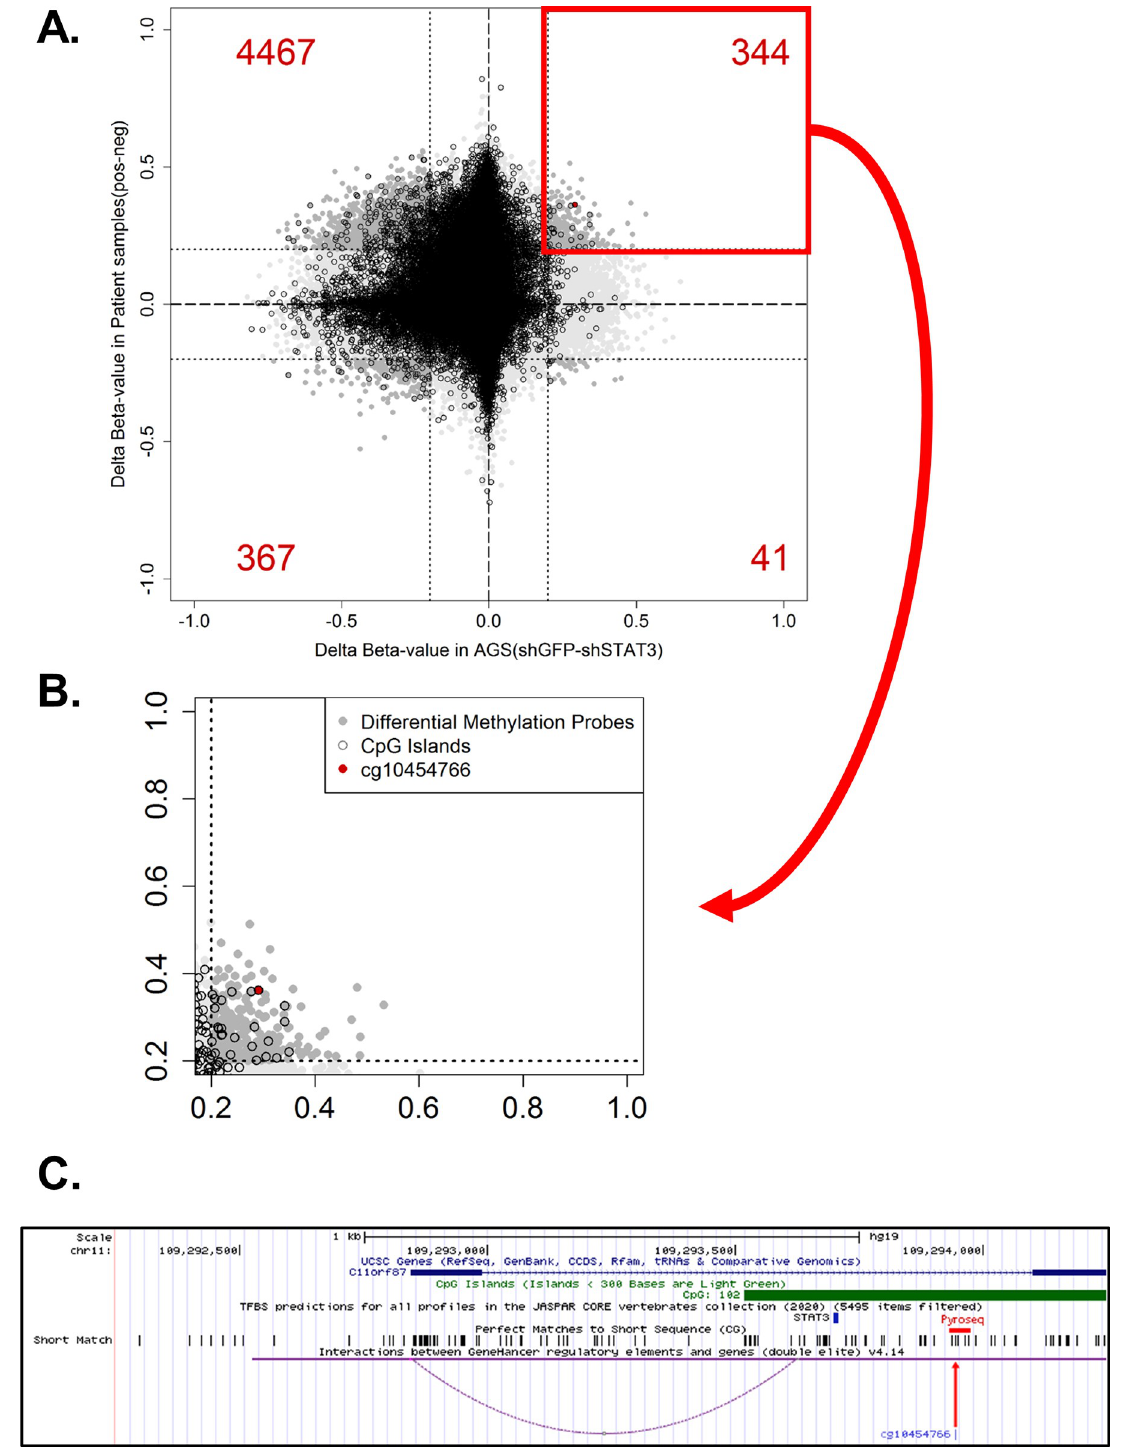
Fig 1. Identification of cg10454766 as a STAT3-mediated hypermethylation loci. (A) Scatter plot showing differential methylation differences in gastric cancer cell lines and patient samples. AGS gastric cancer cell lines (shGFP vs shSTAT3) and gastric cancer patients (STAT3 positive vs STAT3 negative) were subjected to Illumina 850K methylation microarray. The significant differences were defined by 20% methylation changes (0.2 delta beta-value). The amount of significant differential probes showed in red numbers for each quadrat. (B) The selected quadrat denoted STAT3-related hypermethylation. Differential methylation probes showed in dark gray. The probes